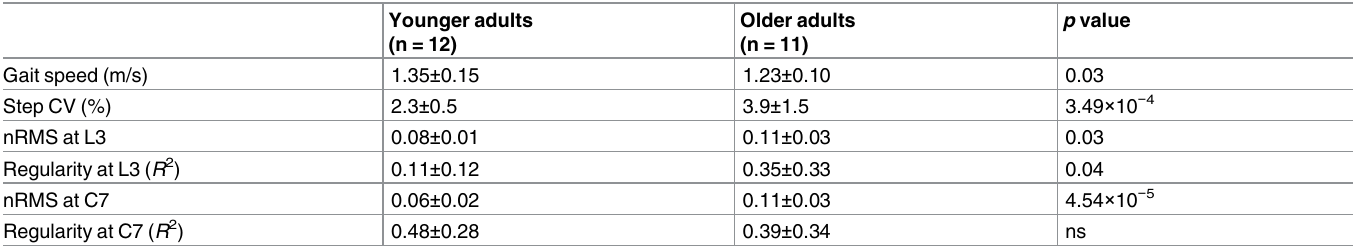
Table 2. Gait speed, step CV, nRMS and regularity at L3, C7 in the ML direction.